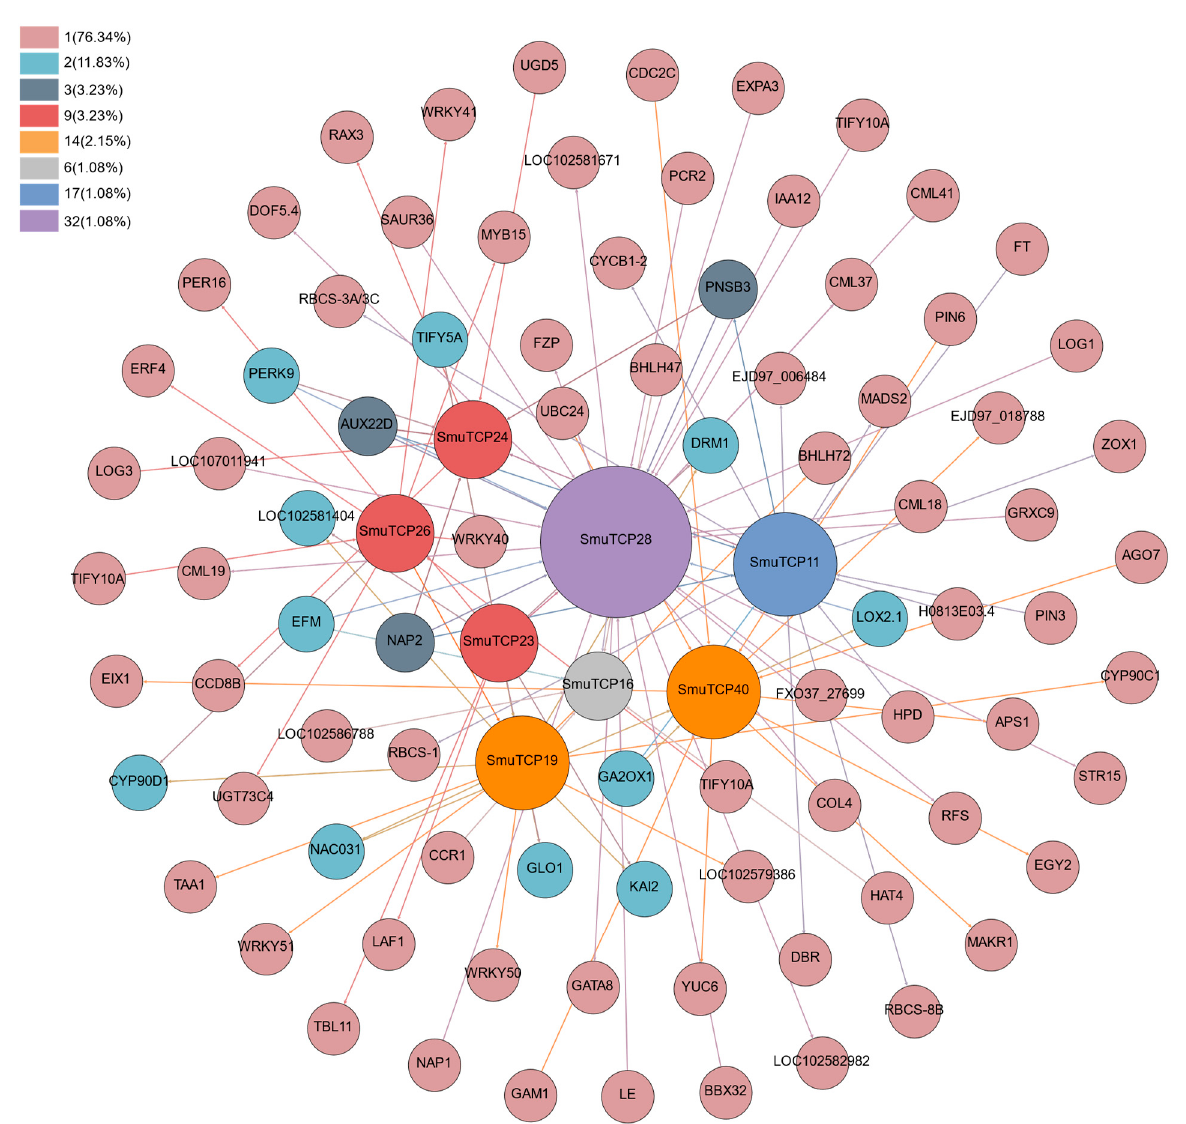
Figure 8. Interaction network between DETCPs and their upstream and downstream regulatory genes in S. muricatum . Note: Different colors represent different degrees of connectivity, the percentages in parentheses indicate the percentage of that degree.